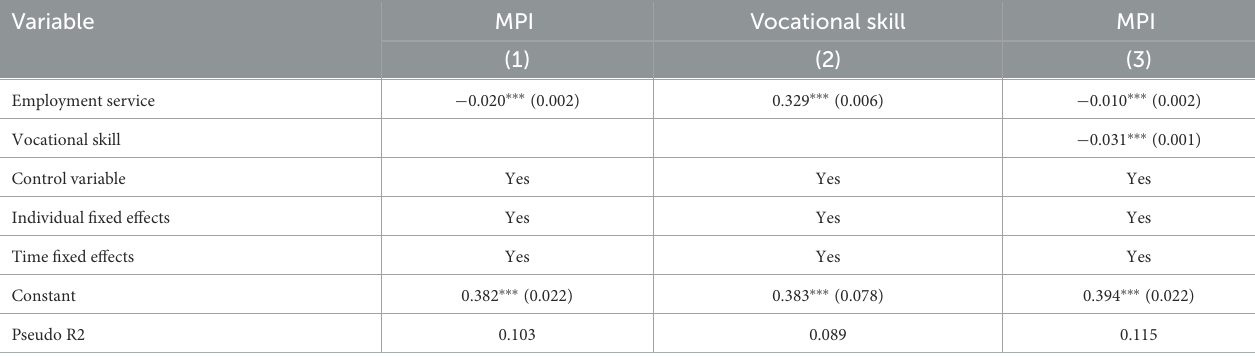
TABLE 11 Results of the mediation effect test of vocational